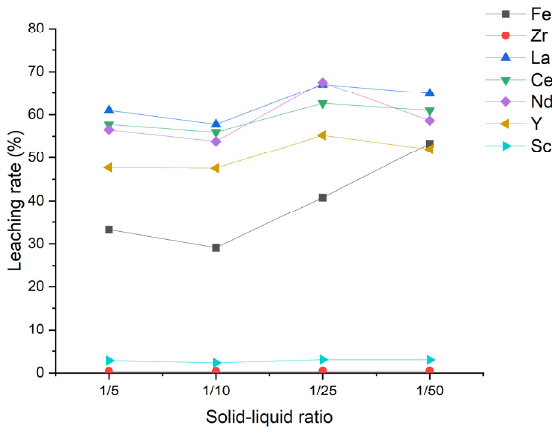
Figure 4. Leaching rates of iron, zirconium, lanthanum, cerium, neodymium, yttrium, and scandium, varying the solid-liquid ratio. Experimental conditions: 100 mL of H 2 SO 4 4 mol/L; T = 25 ◦ C; t = 8 h; stirring speed = 200 rpm.